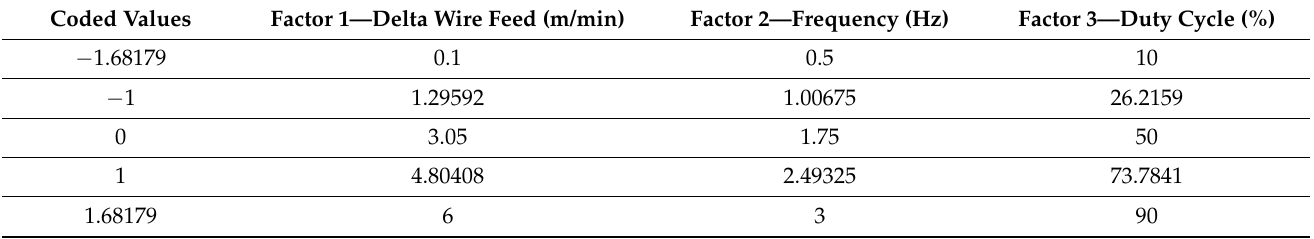
Table 4. Coded values of the experiment design.